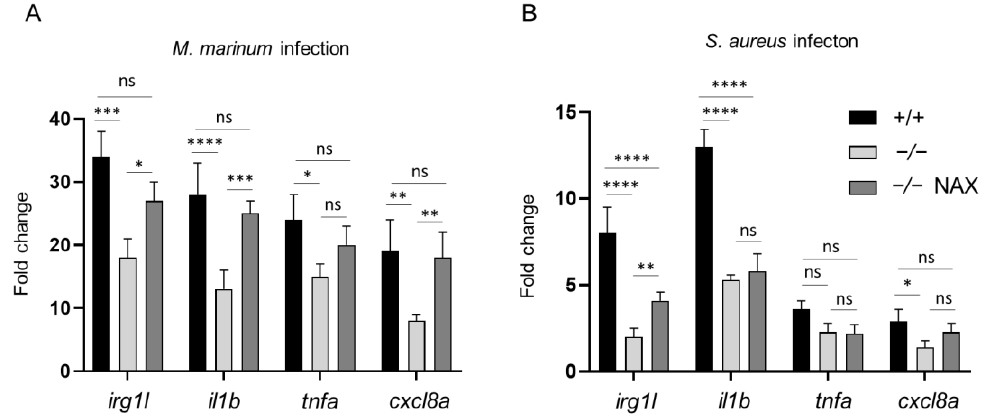
Figure 3. Expression levels of immune-related genes determined by RT-qPCR. irg1l , il1b , tnfa and cxcl8a levels after ( A ) M. marinum or ( B ) S. aureus infection. Data are mean ± s.e.m. of three inde- pendent experiments. * p < 0.05; ** p < 0.01; *** p < 0.001; **** p < 0.0001 (determined using ANOVA